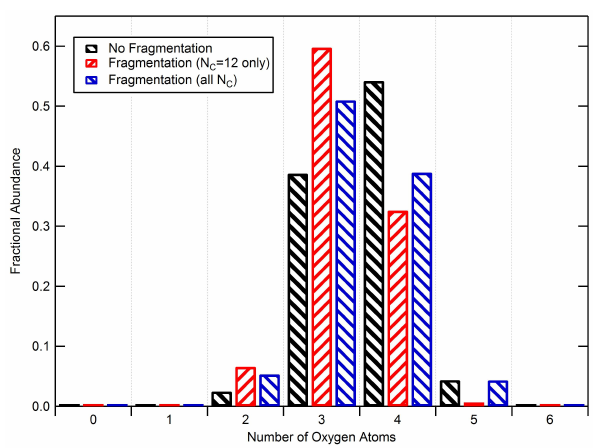
Fig. 4. Calculated distribution of oxygen atoms in the particle-phase after 1 lifetime of reaction for a N C = 12 SOA precursor for cases without fragmentation and with fragmentation (see